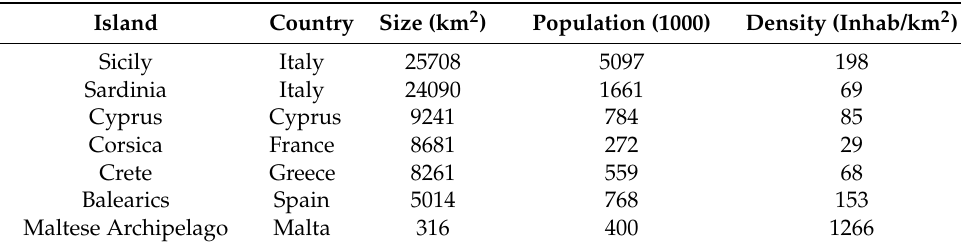
Table 1. Characteristics of the major Mediterranean islands